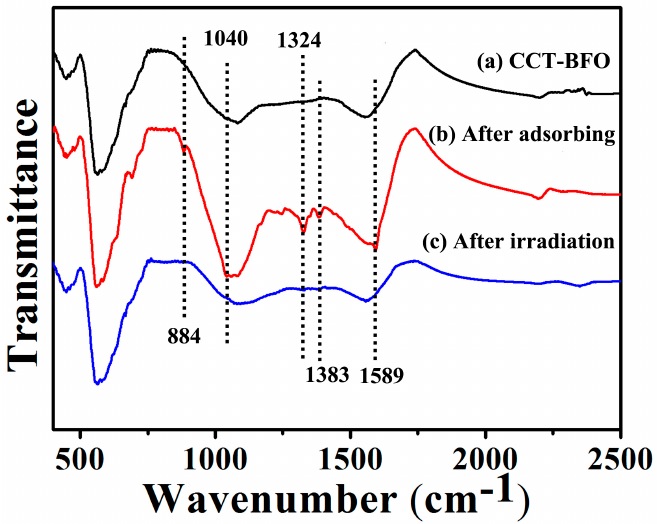
Figure 11. Fourier-transform infrared (FTIR) spectra of ( a ) the as prepared CCT-BFO; ( b ) the CCT-BFO after MB adsorption; and ( c ) the CCT-BFO after being regenerated by photocatalysis.